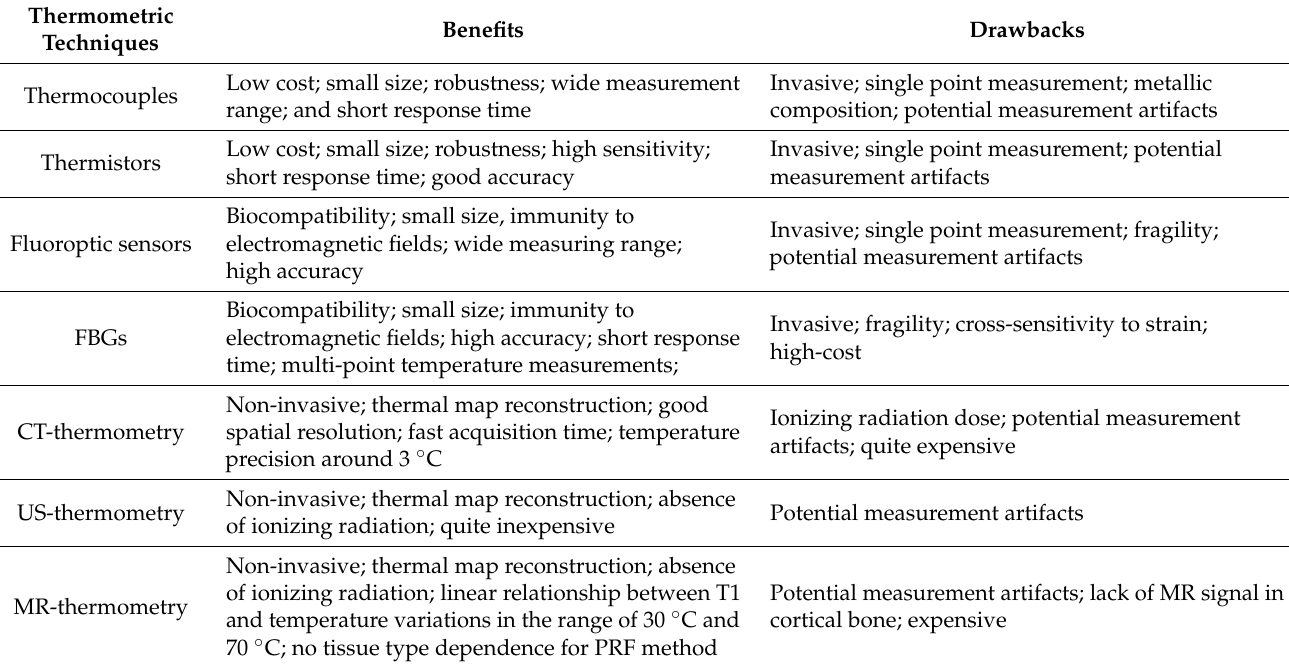
Table 1. Main benefits and drawbacks of thermometric techniques employed during HTs.